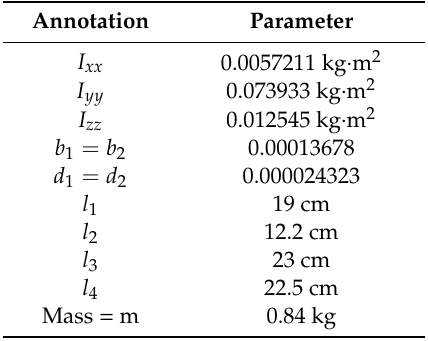
Table 3. Numerical simulation parameters.